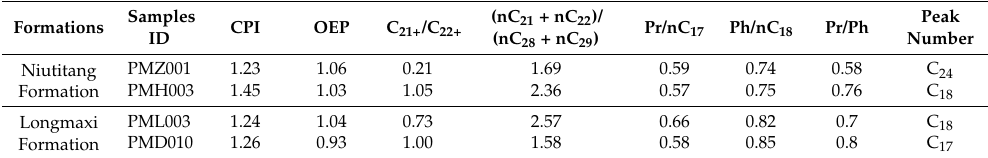
Table 4. Parameters of n-alkanes and is oprenoid.